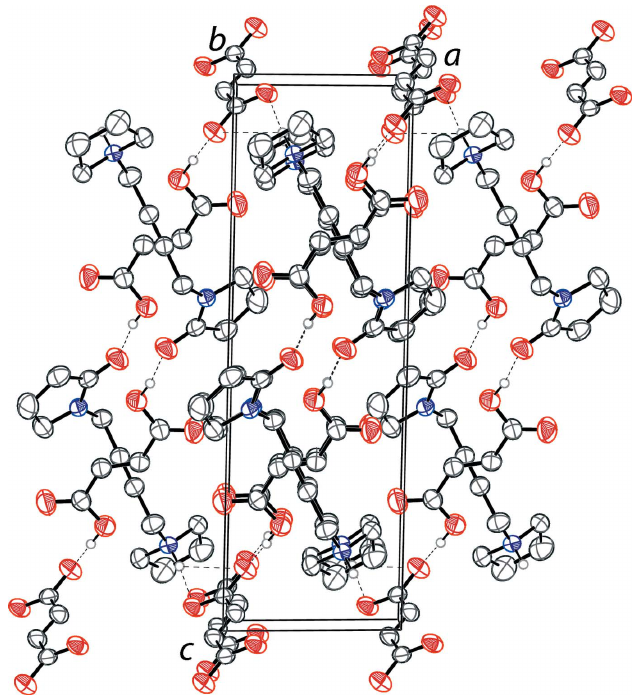
Figure 2 The hydrogen-bonding network forms chains along [001], which consist of R 6 (40) rings that are joined together by the fumarate dianions. The ring 6 structure is shown above. Hydrogen atoms not involved in hydrogen bonds, and the second component of the disordered fumarate dianion are omitted for clarity.